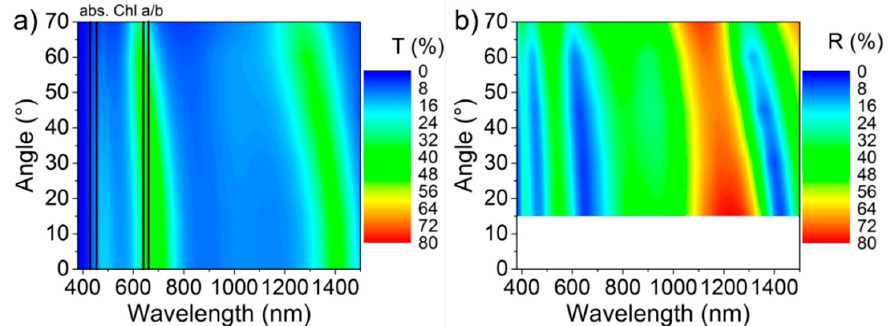
Figure 11. Color plots of the angle dependence of a spectrally-selective solar cell. Transmission T with the absorption maxima of chlorophyll a/b ( a ) and the corresponding reflection R ( b